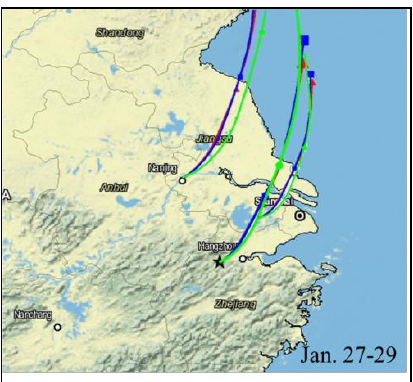
Atmosphere 2020 , 11 , x FOR PEER REVIEW Figure 4. Source apportionment of the fine particles on polluted ( a ) and clean ( b ) days.